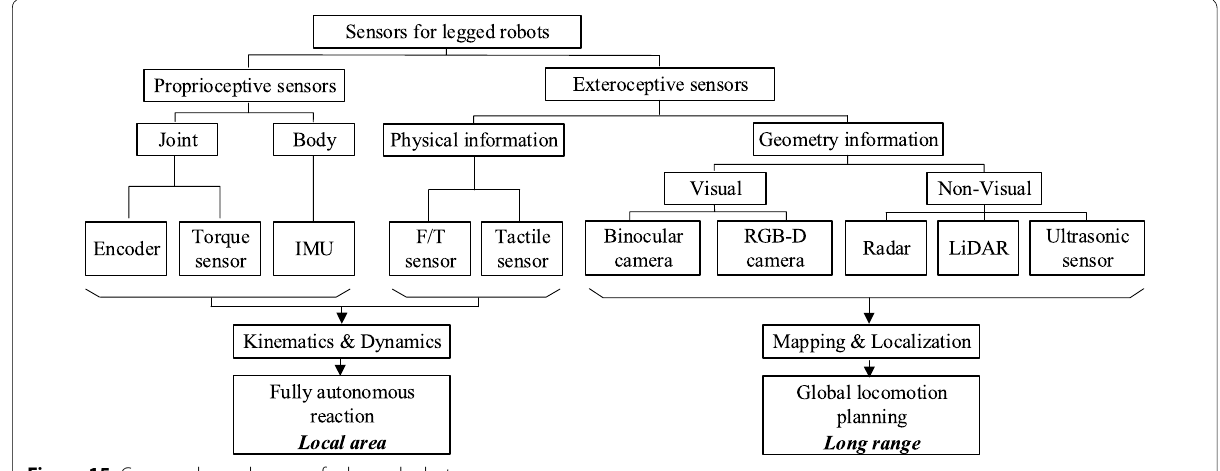
Figure 15 Commonly used sensors for legged